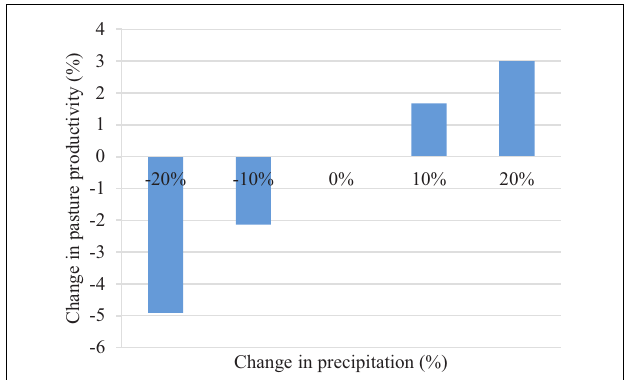
FIGURE 9 | The compared graph of precipitation changes on pasture productivity.